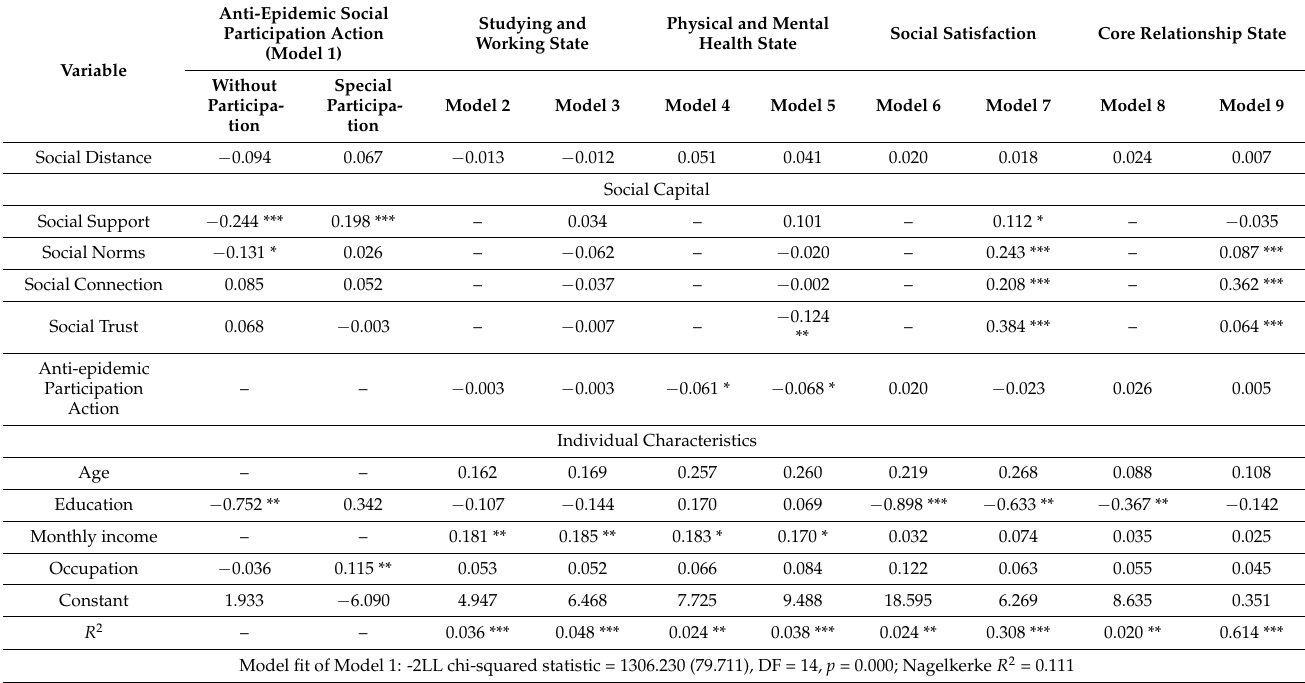
Table 4. Regression Analysis of Youth Anti-Epidemic Action and Its